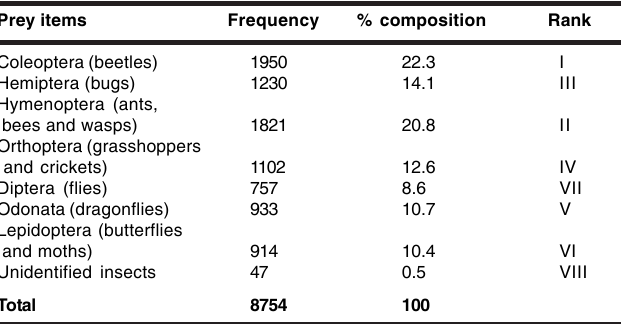
Table 3. Frequency and percent composition of various prey items in the diet of the Small Bee-eater